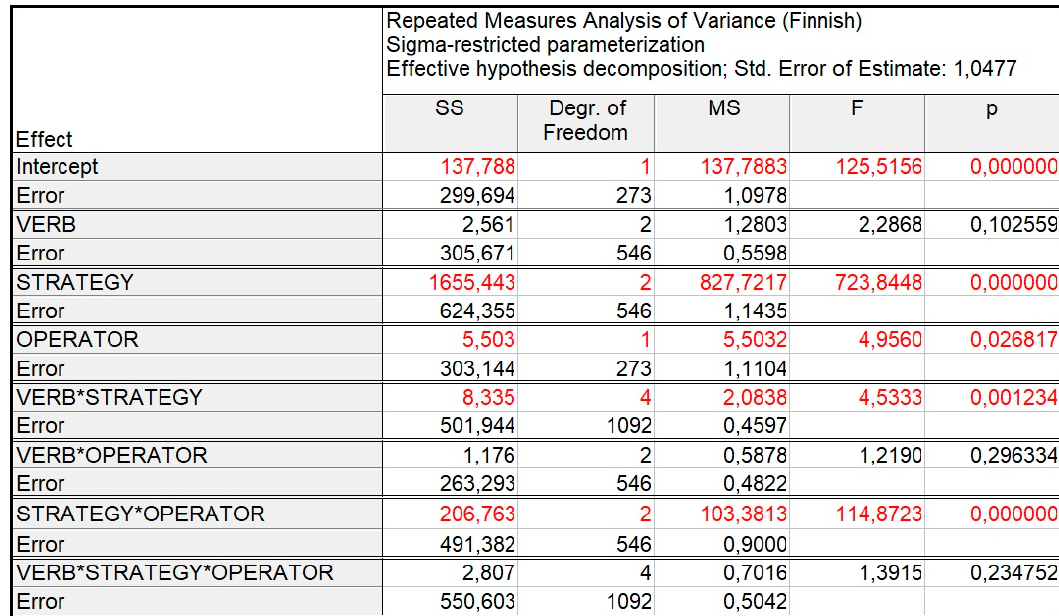
Figure 4. Factors’ effect and their interactions (Finnish).